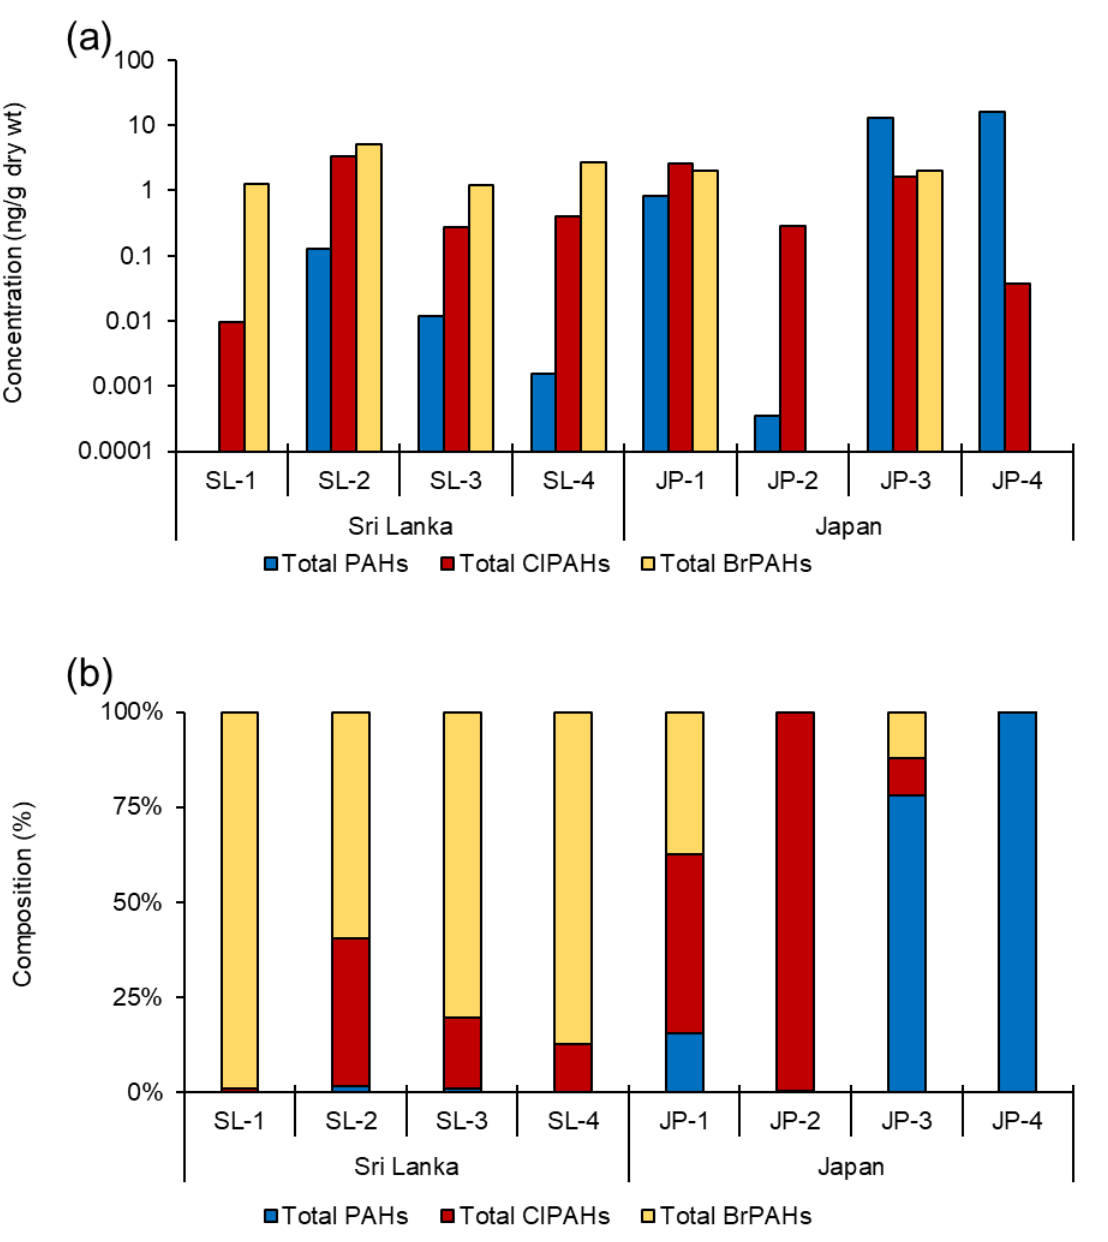
Figure 1. ( a ) Concentration of polycyclic aromatic hydrocarbons (PAHs), chlorinated polycyclic aromatic hydrocarbons (ClPAHs), and brominated polycyclic aromatic hydrocarbons (BrPAHs) (ng/g dry weight) in milk powder samples from Sri Lanka and Japan. ( b ) Composition of total PAHs, ClPAHs, and BrPAHs in milk powder samples from Sri Lanka and Japan.